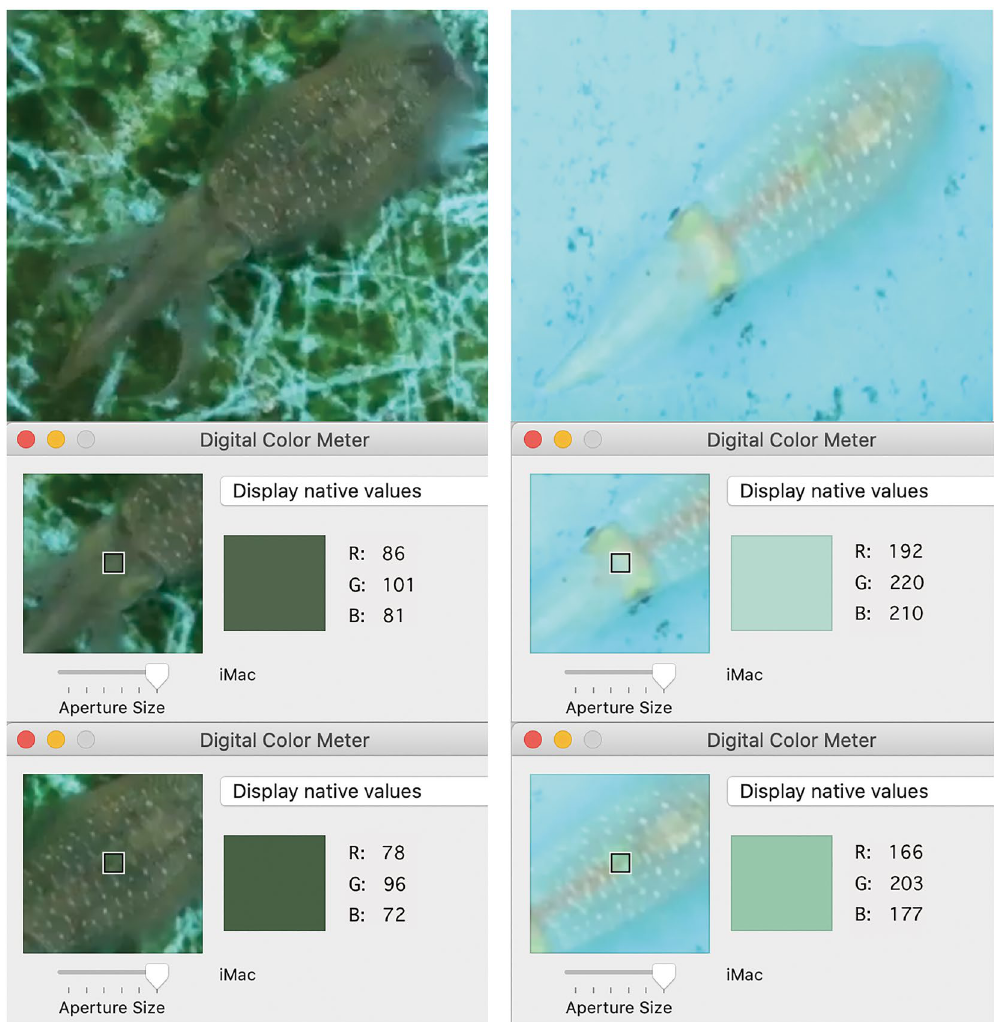
with activity of animal